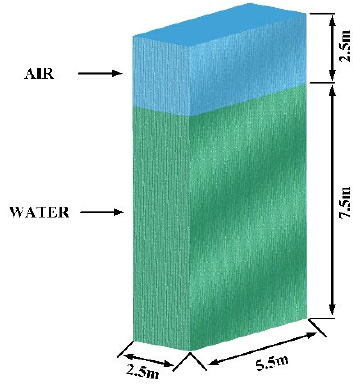
Figure 2. Calculation domain size. Table 1. Material parameters.